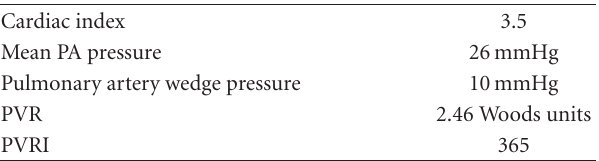
Table 1: Right heart catheter